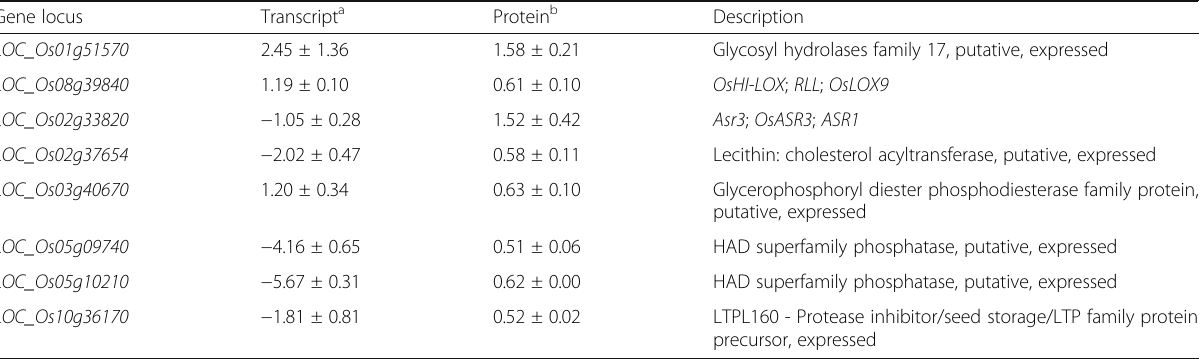
Table 2 Expression pattern of DEGs and DEPs identified in both transcriptomic and proteomic analyses Gene